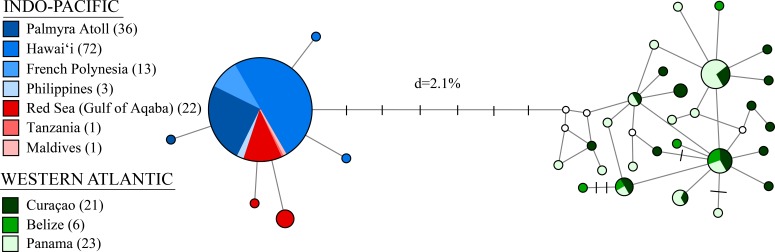
A median-joining network for 198 individuals of Stenopus hispidus based on 525 bp of the cytochrome c oxidase subunit I (COI) gene.Total numbers of individuals collected at each location are in parenthesis. Each circle represents a unique haplotype and its size is proportional to its total frequency. Lines and each black crossbar represent a single nucleotide change whereas open white circles indicate unsampled haplotypes. The network depicts two distinct lineages separated by seven mutational steps and a sequence divergence (d) of 2.1%.